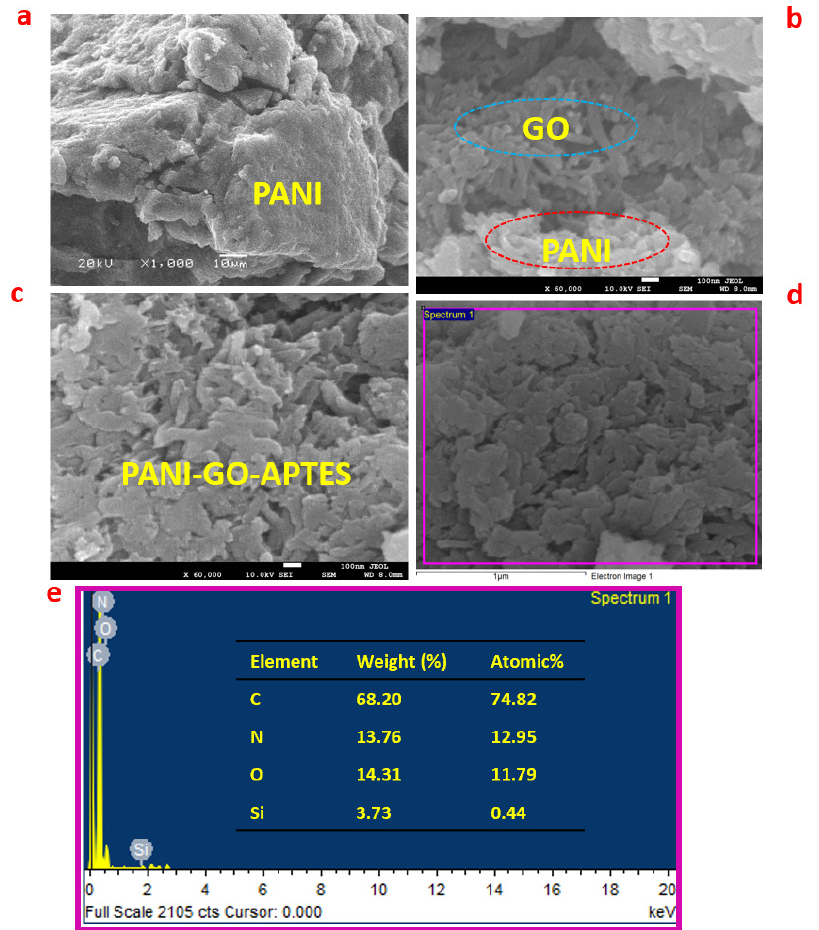
Figure 1. ( a ) SEM image of polyaniline. ( b ) SEM image showing grafting of GO on PANI substrate. ( c ) The magnified SEM image of PANI-GO. ( d ) SEM image of PANI-GO-APTES. ( e ) XEDS of PANI- GO-APTES.